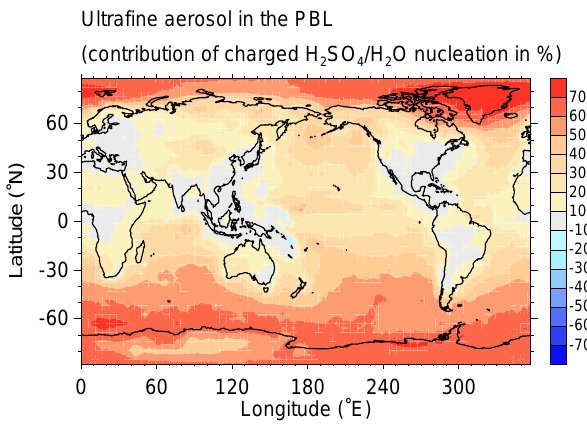
Fig. 6. Contribution of charged H 2 SO 4 /H 2 O nucleation in simula- Fig.6. Contributionofcharged H 2 SO 4 / H 2 O nucleationinsimulation S ref totheannualmeanconcentrationofultrafineaerosol(particles with > 3nmdrydiameter)intheplanetaryboundarylayer. tion S ref to the annual mean concentration of ultrafine aerosol (par- ticles with > 3nm dry diameter) in the planetary boundary